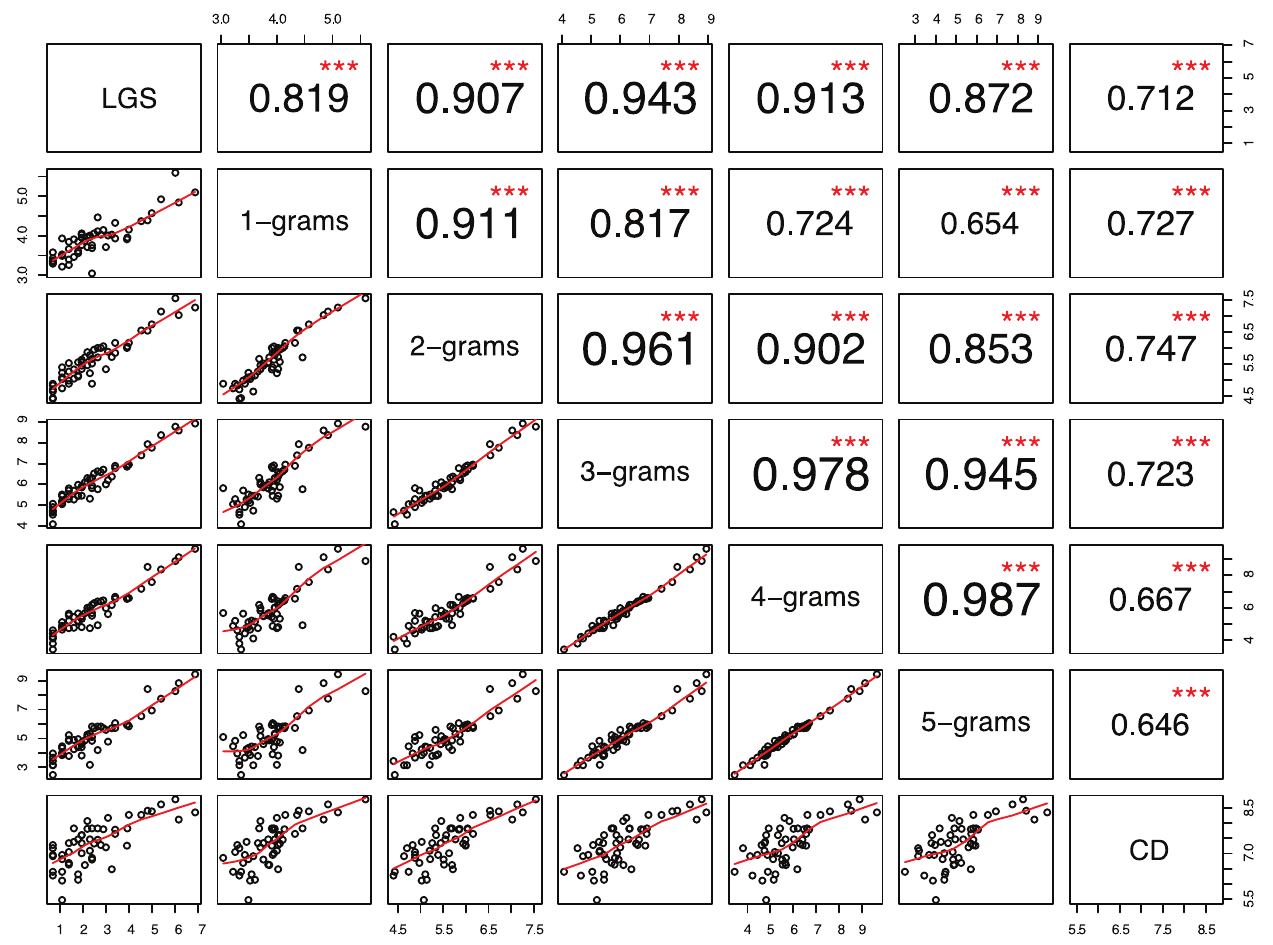
Figure 2. Pairwise scatterplot matrix of group size, N -gram diversity and date; the lower matrix panels show scatterplots and LOESS lines; the upper matrix panels show Spearman rank correlation ( r ) and level of statistical significance ( ? ). The diagonal panels display variable names. All the plots are on a log-log scale.